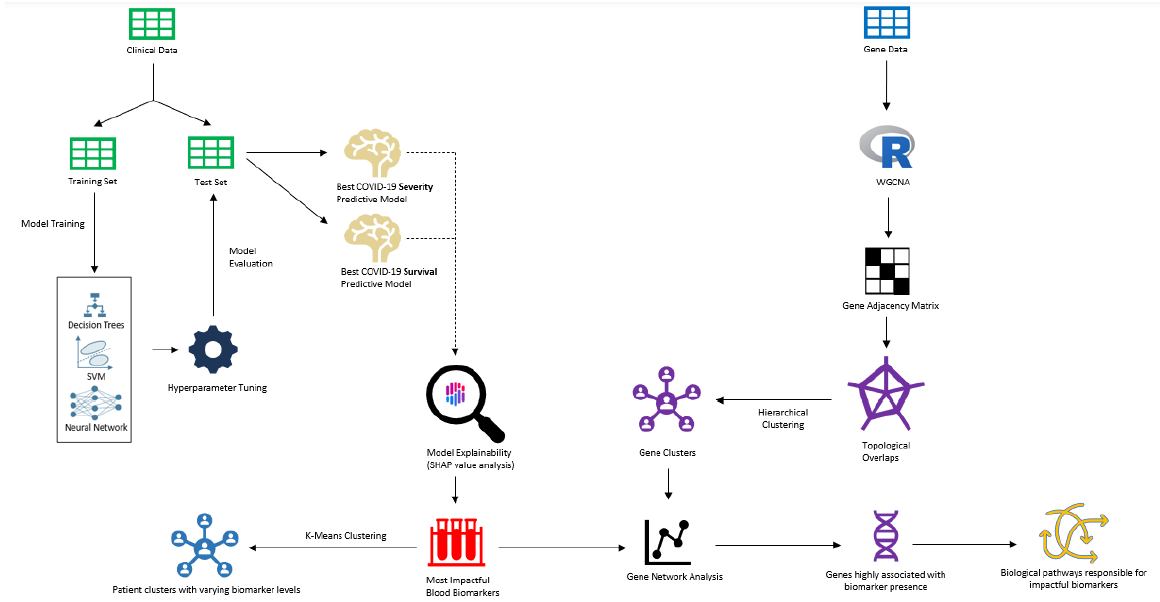
Figure 1 . Overview of the workflow for an AI/ML-driven model that predicts the outcome of COVID-19 infection in patients, utilizing a set of clinical biomarkers and genomics dataset.